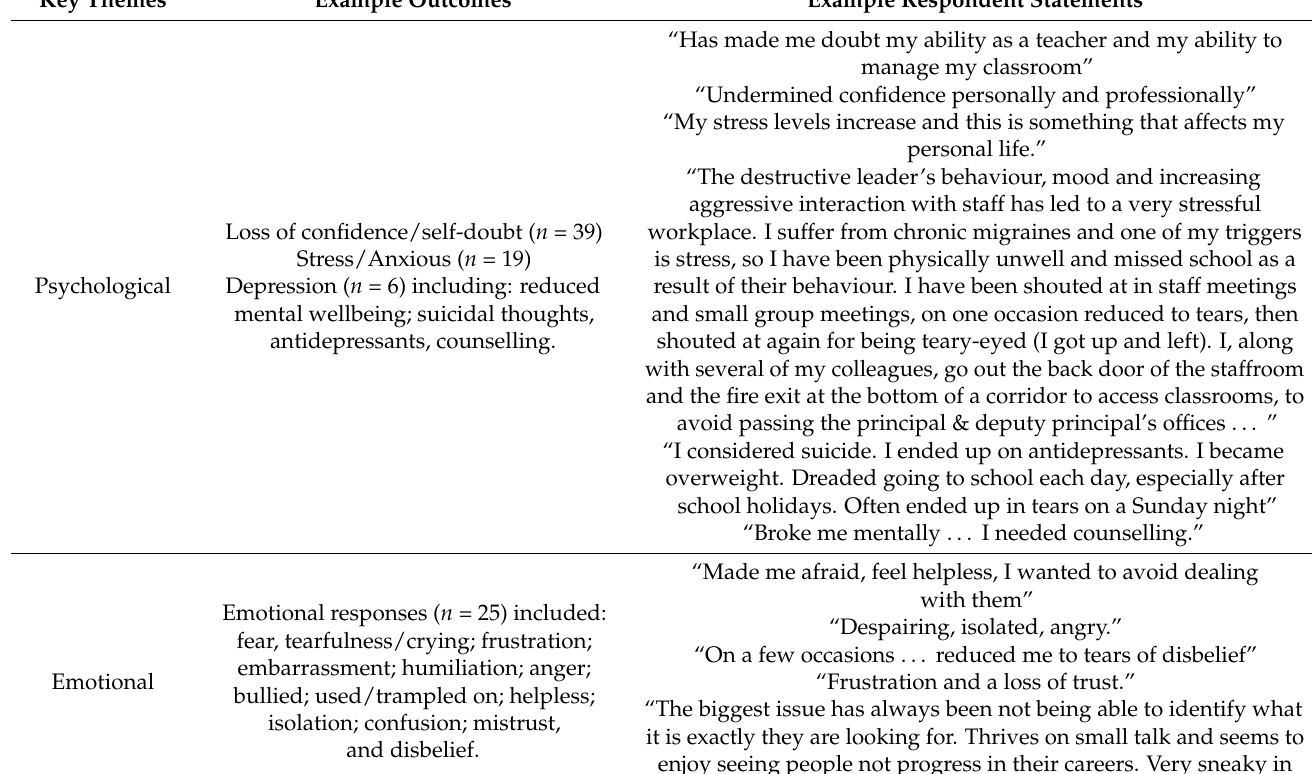
Table 9. Personal impact on participants of toxic leadership.